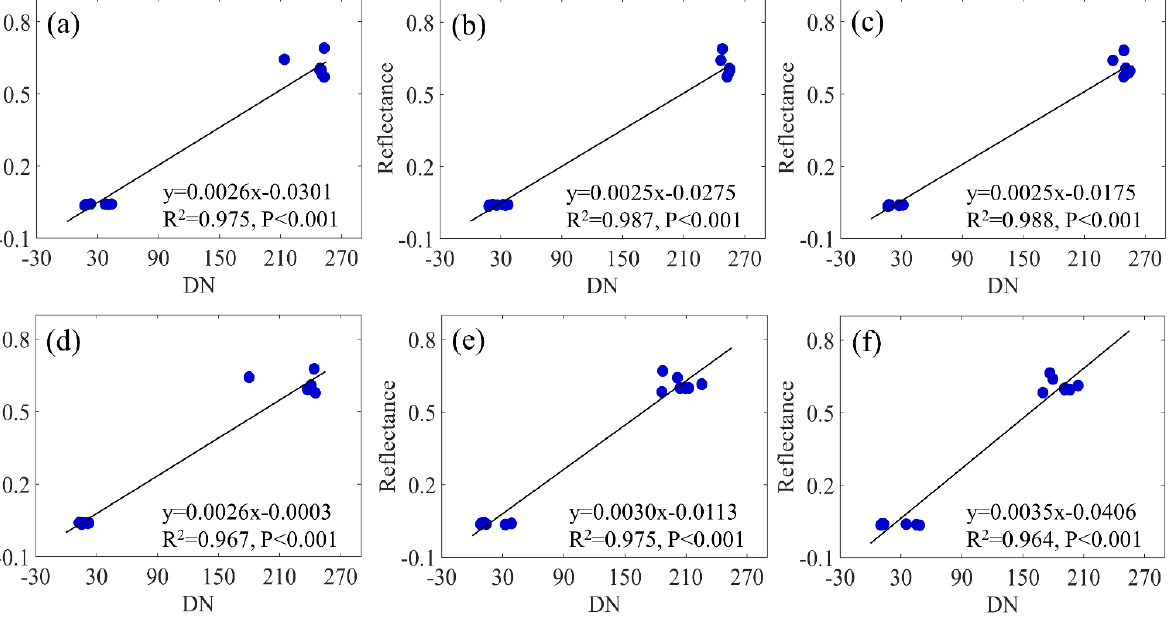
Figure 4. The scatter plots of DN from multi-spectral images and reflectance from ASD-HH2. Note: each dot in sub-image represents one calibration target. ( a ) band 1: 490 nm, ( b ) band 2: 550 nm, ( c ) band 3: 670 nm, ( d ) band 4: 700 nm, ( e ) band 5: 800 nm and ( f ) band 6: 900 nm.